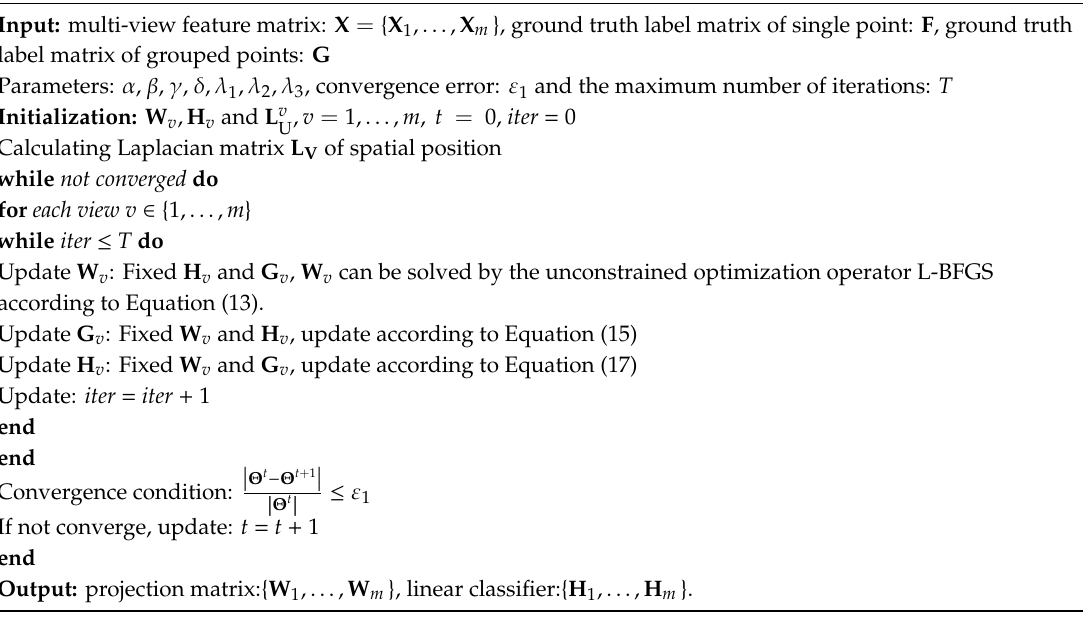
Algorithm 1: MvsRCLC optimization algorithm (The pseudocode of the multiple views and space representation consistency under constraints of label consistency (MvsRCLC) optimization